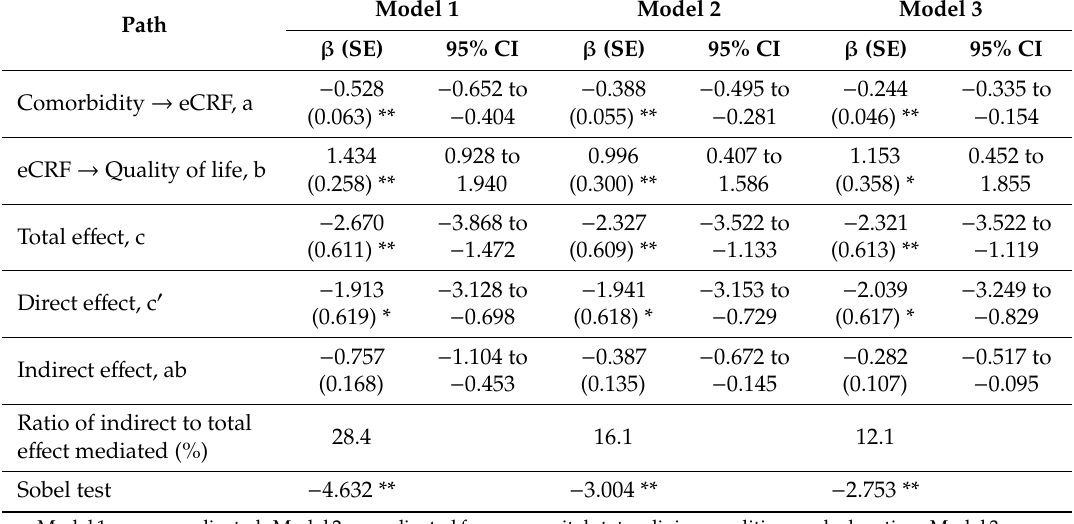
Table 4. The association between comorbidity and health related quality of life, mediated by eCRF, in